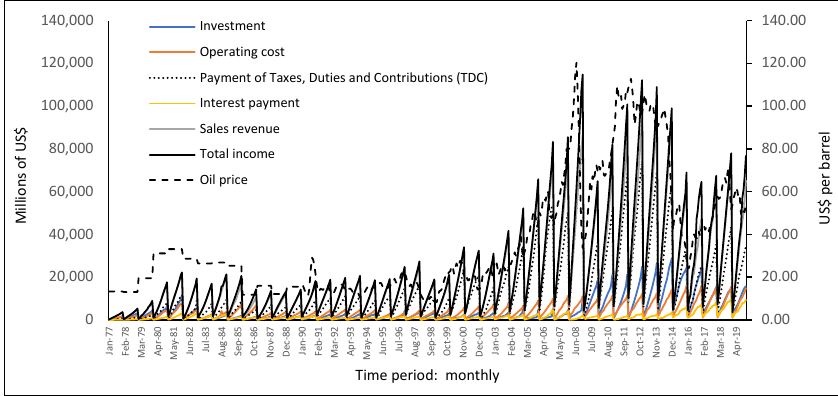
Figure 5. Oil price and Pemex ’ s financial indicators, 1977 – 2019